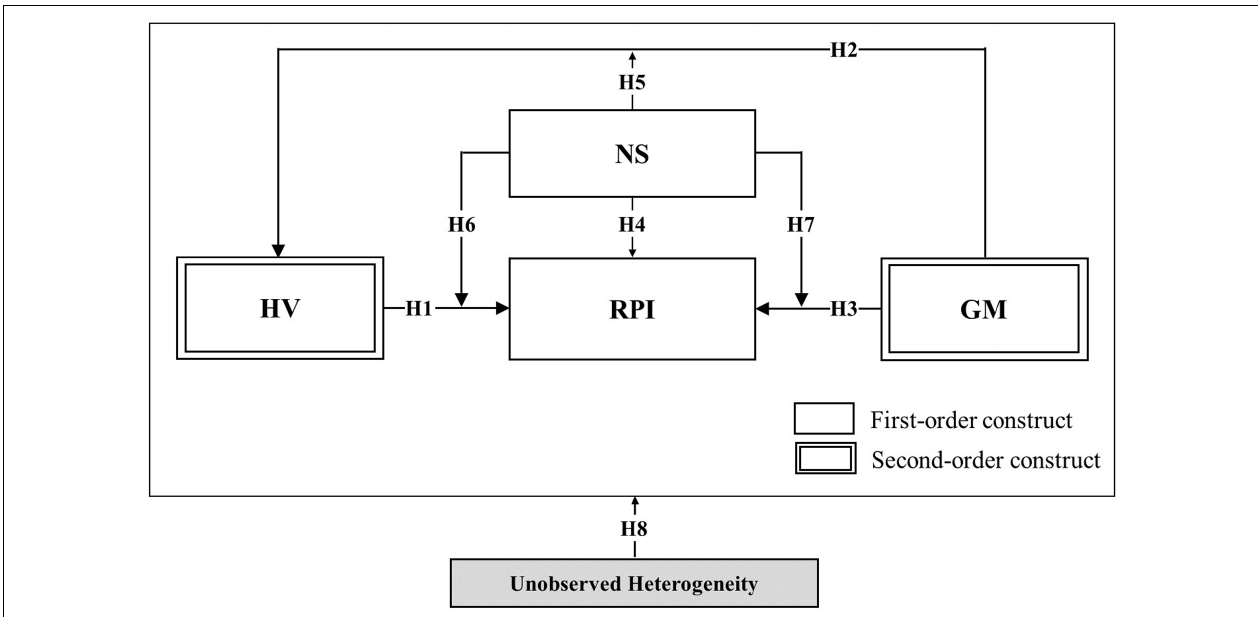
FIGURE 4 | Proposed final research model in the context of omnichannel